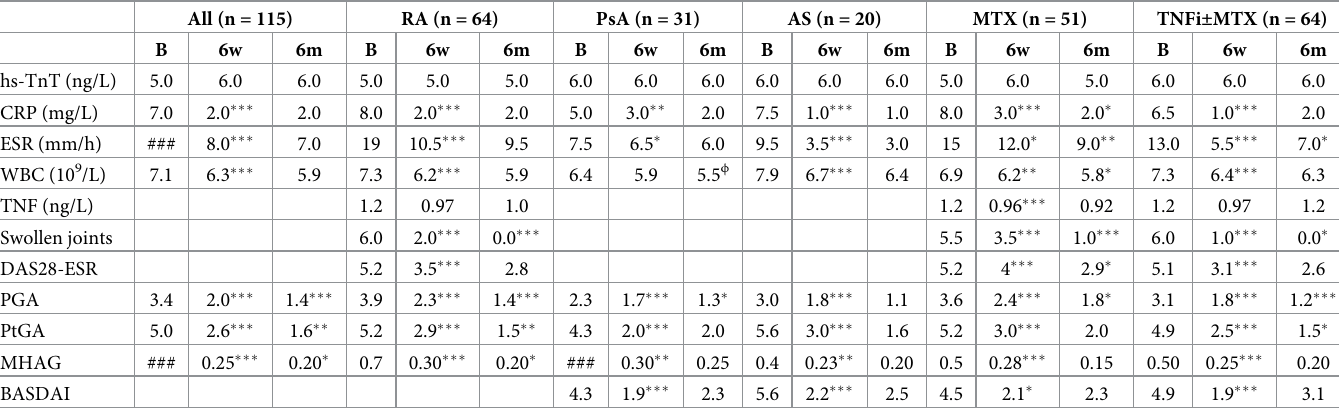
Table 3. Changes in hsTnT and some selected clinical and laboratory